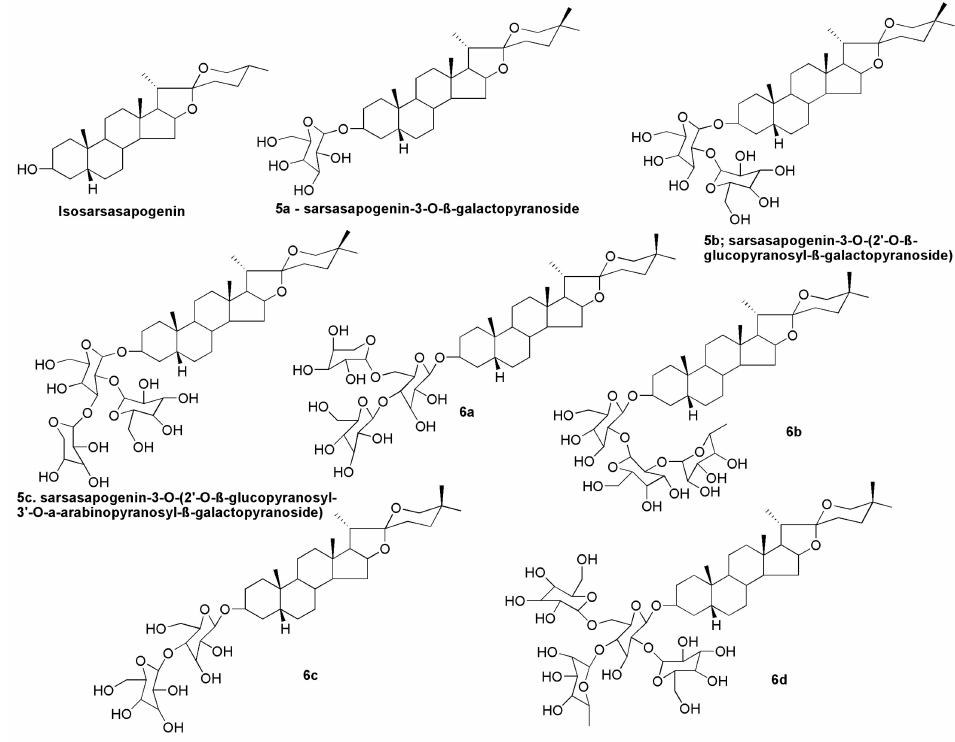
Figure 9. Chemical structures of isosarsasapogenin and other sarsasapogenin-derived compounds ( 5a – 5c and 6a – 6d